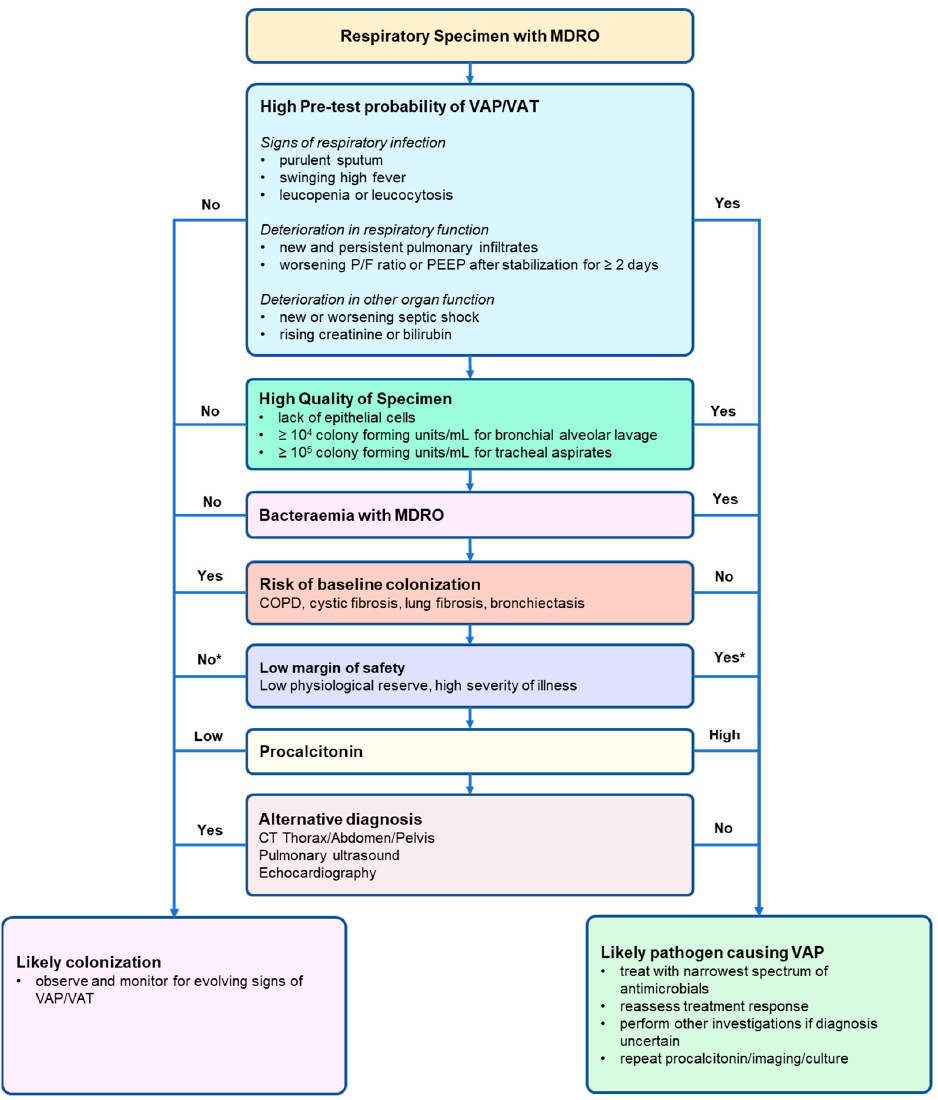
Figure 2. Outline of key factors to be considered when deciding to treat or not to treat when a ventilated patient has a positive MDRO respiratory specimen. The final decision is based on the final weight of evidence either in favor of likely VAP or not, after systematic consideration of these multiple factors. See text for further explanation. * Does not change the likelihood of VAP diagnosis but does reduce the safety margin of withholding targeted antimicrobial therapy. MDRO, multidrug resistant organism; PEEP, positive end-expiratory pressure; P/F, PaO 2 /FiO 2 ; VAP, ventilator-associated pneumonia; VAT, ventilator-associated